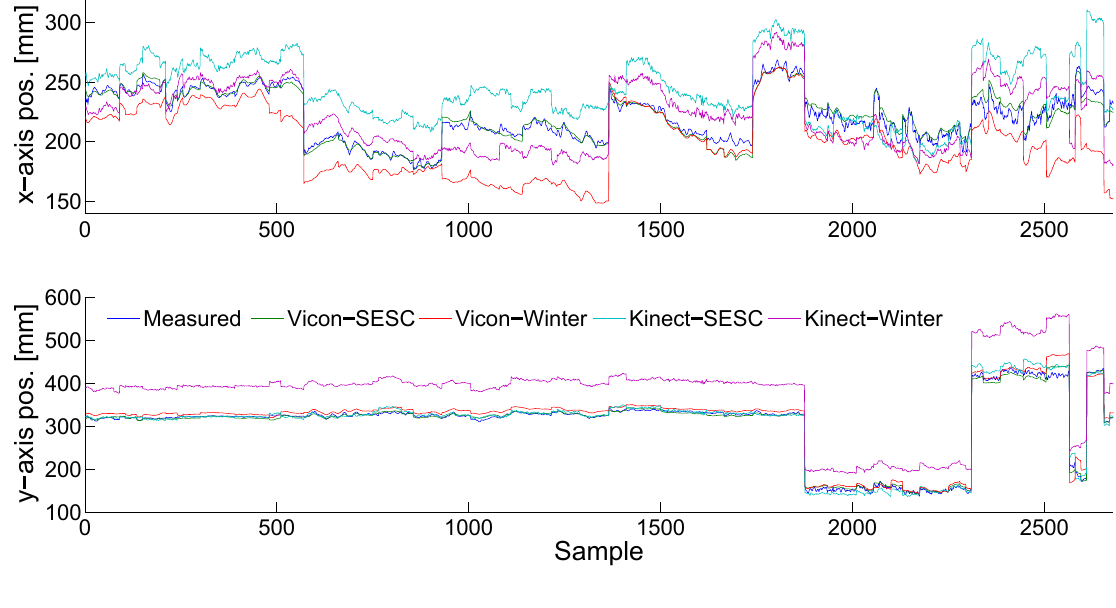
Figure 4. Summary of the performance of each CoM estimation method. The bars correspond to the rmse (cid:6) std averaged for all seven subjects. We observe an increase in the accuracy of the identified SESCs with respect to the literature estimates [10]. In addition, the performance of the Kinect-SESC was found to be equivalent to that of the literature-based estimate using high-end